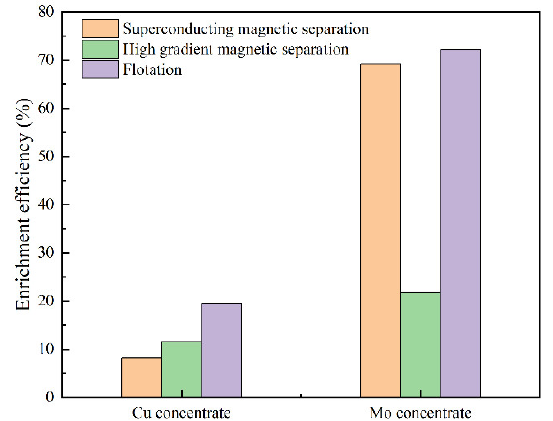
Figure 9. Comparison of enrichment efficiency of different methods; superconducting magnetic separation with magnetic induction of 7 T, pulp concentration of 20%, and feed velocity of 5 L/min; high gradient magnetic separation [24] with magnetic induction of 1.8 T, pulp concentration of 11.17% and feed velocity of 4 L/min; flotation [25] with kerogen 8 mg/L and terpenic oil 20 mg/L, pH 8.